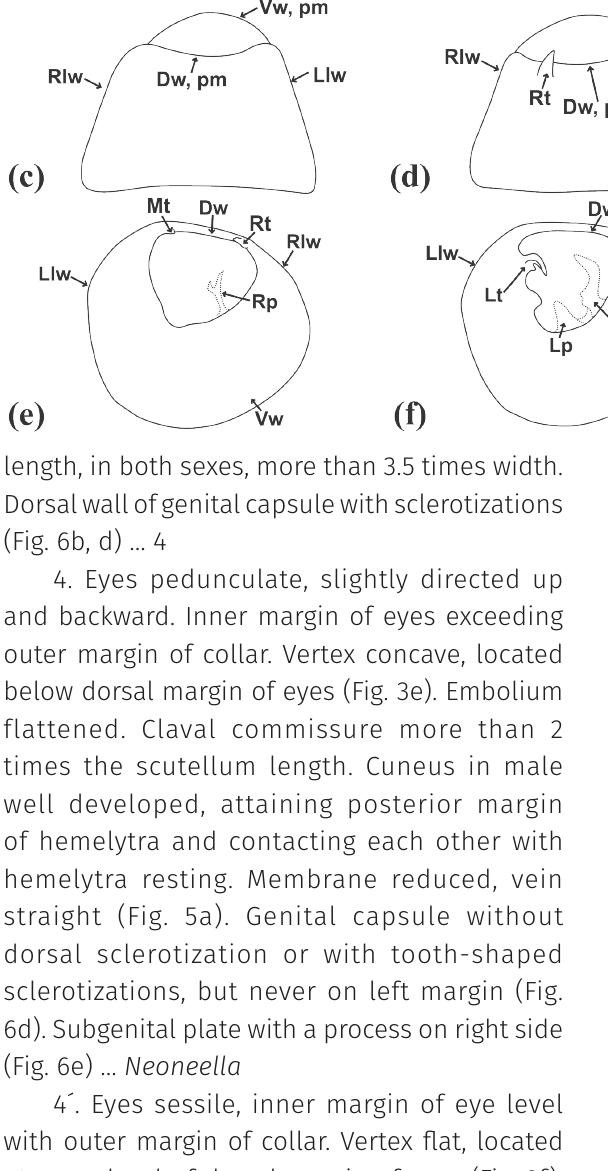
Figure 6. Schematic drawings of the genital capsule. (a, e-f) posterior view; (b) laterodorsal view; (c-d) dorsal view; (a) Adneella osunai Carvalho 1989; (d, e) Neoneella bosqui Carvalho 1946 ; (b, f) Proneella boliviana Carvalho 1960 ; (c) Neella eucosma (Stål 1862) Reuter 1908 . Abbr. Dw : dorsal wall. Dw, pm : dorsal wall, posterior margin. Llw : Left lateral wall. Lp : Subgenital plate left process. Lt : sclerotized left tooth. Mt : sclerotized medial tooth. Rlw : right lateral wall. Rp : Subgenital plate right process. Rt : sclerotized right tooth. Sb : supragenital bridge. Vw : ventral wall. Vw, pm : ventral wall, posterior